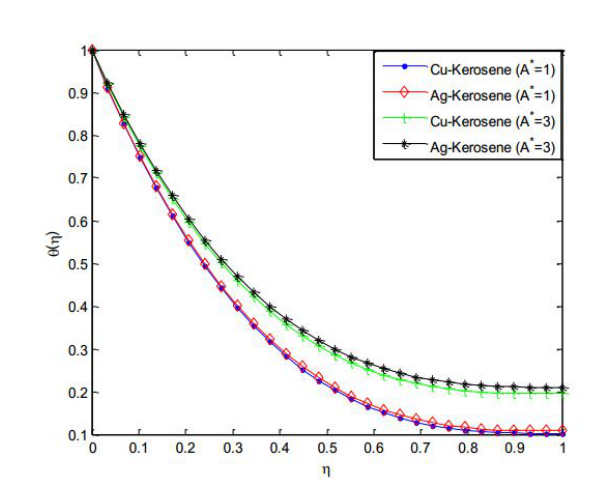
Figure 18. Effect of non-uniform heat source/sink parameter (A*) on the fluid temperature